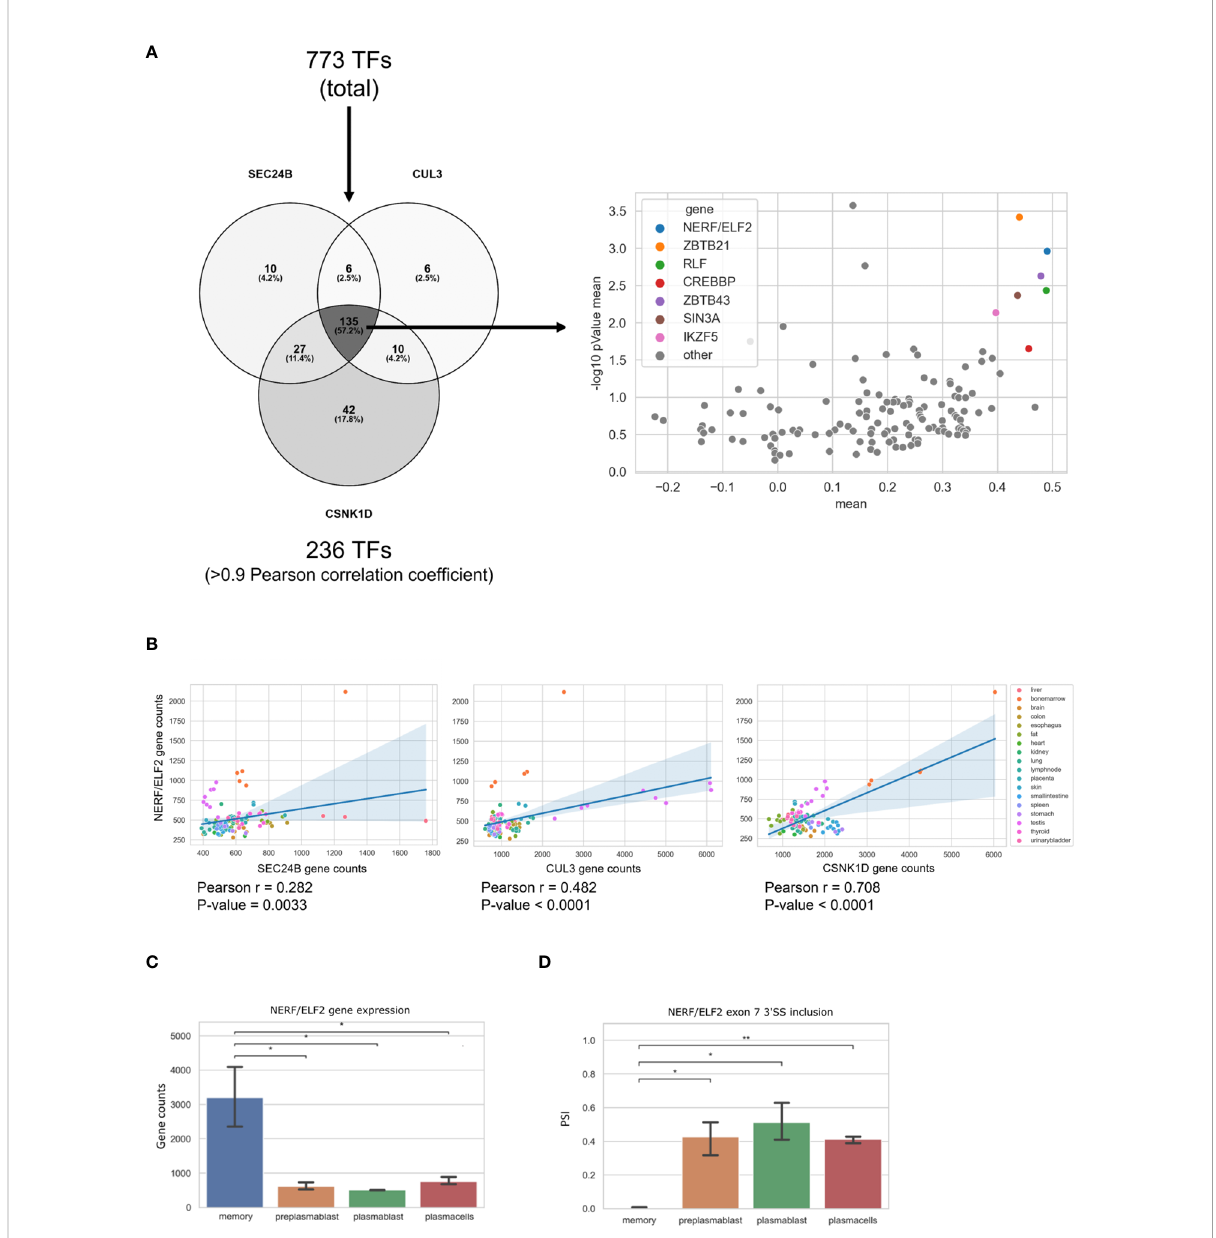
FIGURE 5 NERF/ELF2 controls expression of COPII-related genes in MBCs. (A) Venn diagram showing the TFs that had a high Pearson correlation coef fi cient (>0.9) with SEC24B , CUL3 , and CSNK1D in MBCs (left). Dotplot showing the Pearson correlation coef fi cient of the 135 TFs and the SEC24B , CUL3 , and CSNK1D genes in publicly available RNA-seq data of 17 human tissues (SRA study ERP003613). Shown in the graph is the mean pearson correlation coef fi cient against the mean p-value of the correlation in -log10 scale of each TF with the three COPII genes (right). (B) Dotplot with added linear regression line for the correlation between NERF/ELF2 and SEC24B , CUL3 , and CSNK1D in human tissue data. Each dot is color coded for originated tissue. (C) NERF/ELF2 gene expression in B cells. (D) NERF/ELF2 alternative splicing pattern of Exon 7 3'SS in B